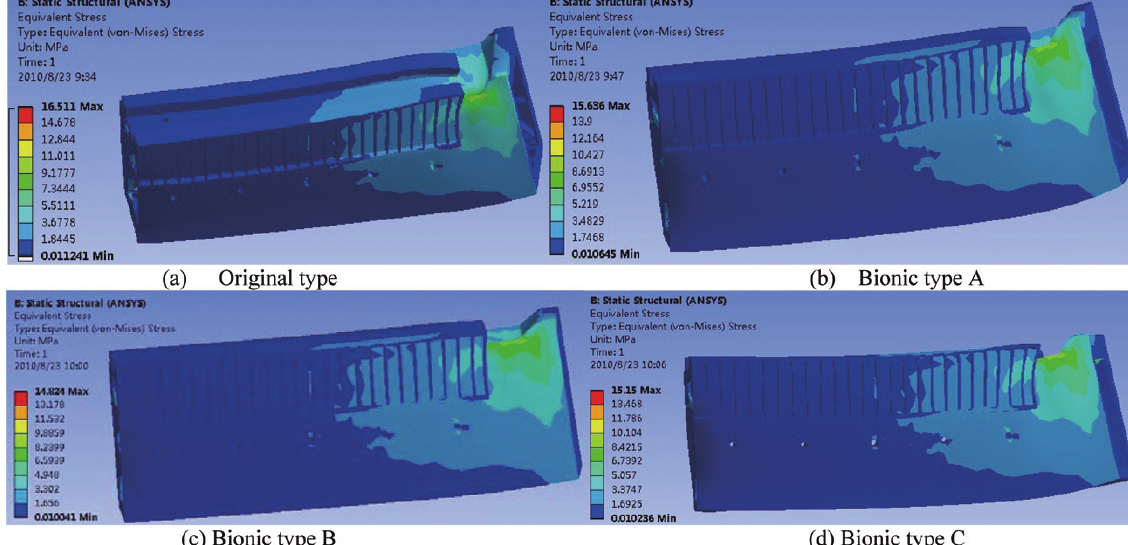
Fig. 9. The von-Mises stress of columns.